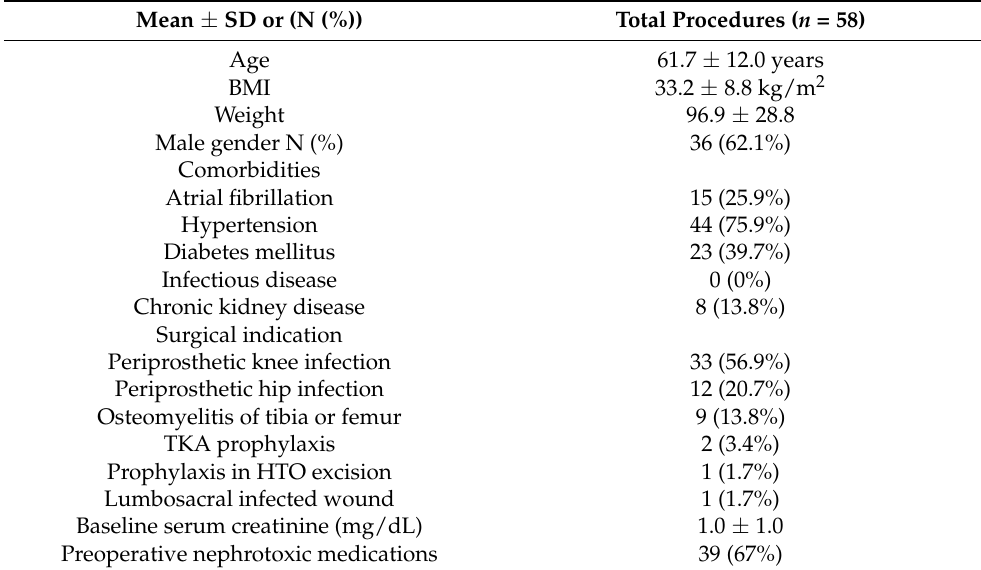
Table 1. Summary of baseline demographics at time of procedure.